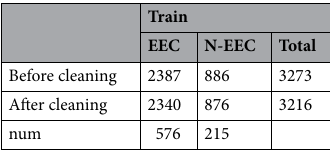
Table 3. Comparison of esophageal image data sets before and after cleaning.